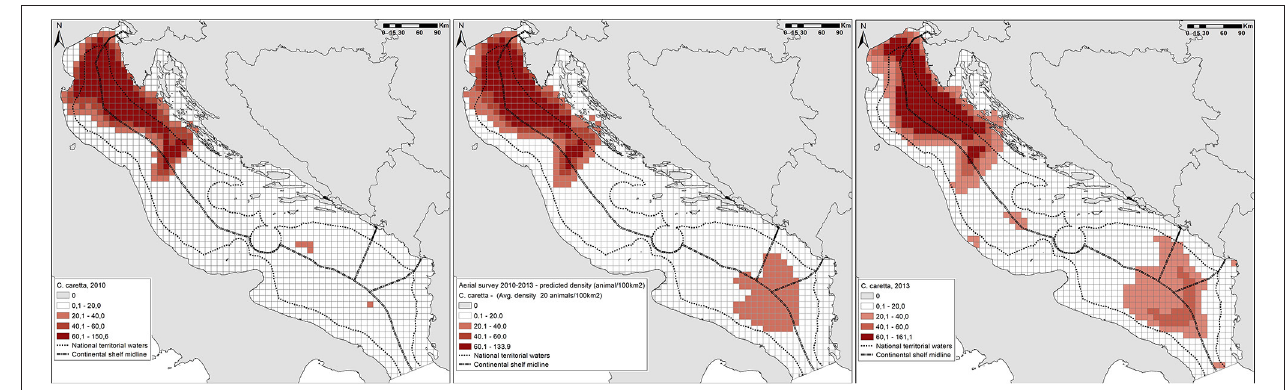
FIGURE 4 | Loggerhead turtle densities for the data from 2010 (left); 2010 + 13 (center), and 2013 (right). The scales represent below average and then twice, three times, and greater than three times average density (shades of dark